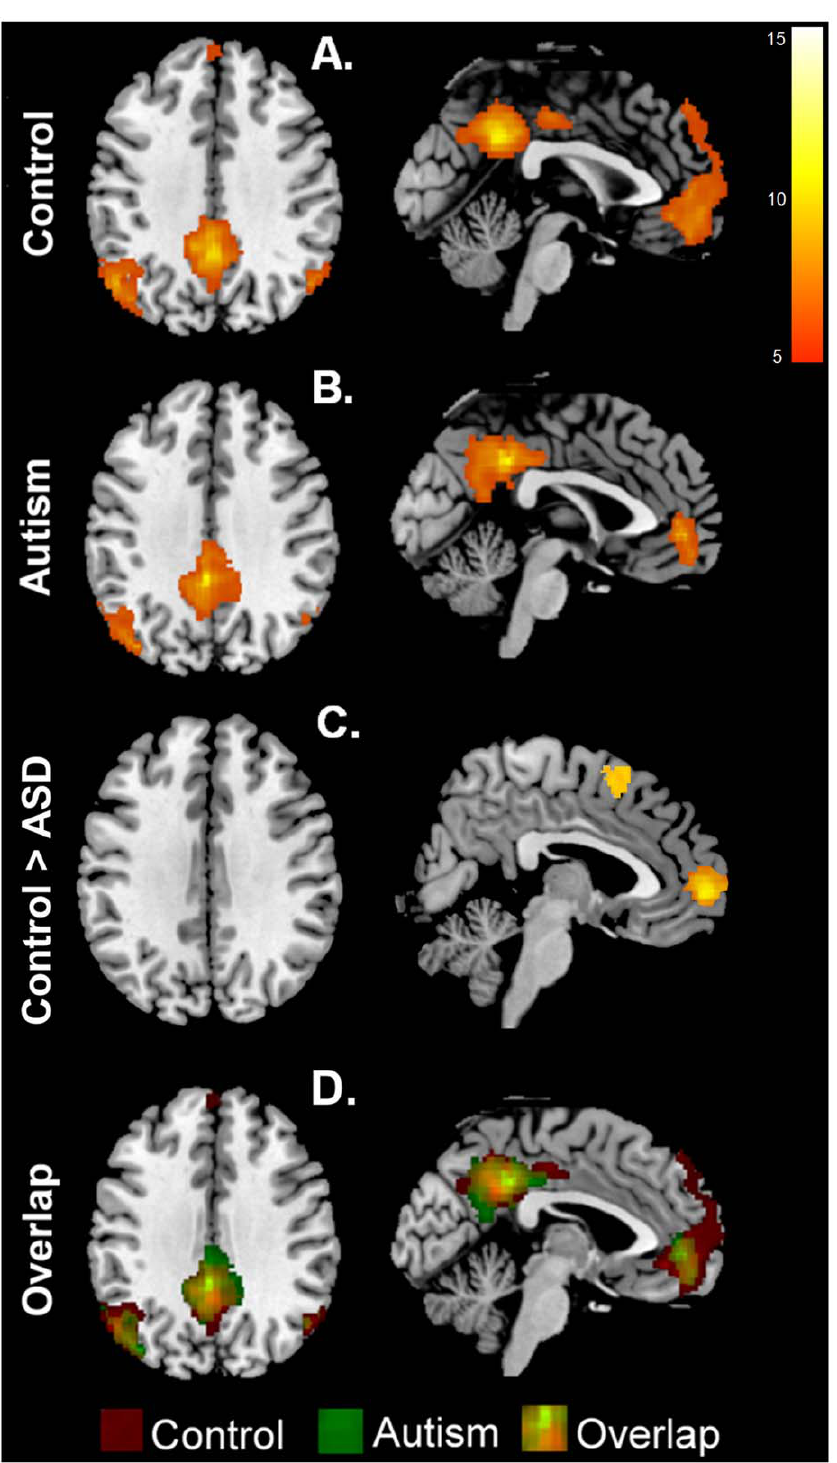
Figure 3. The averaged DMN connectivity map (p , 0.001, cluster corrected). Significant clusters shown are represented as z scores. (A) DMN map for the control group. (B) DMN map for the ASD group. (C) DMN map of regions with greater connectivity in control participatns than participants with ASD. (D) Overlap of the control and ASD connectivity maps. doi:10.1371/journal.pone.0050064.g003 identification of control group (See Figure S3, S4 and Table S1 for and caution should be taken in interpreting the connections with the highest classification weights [38].